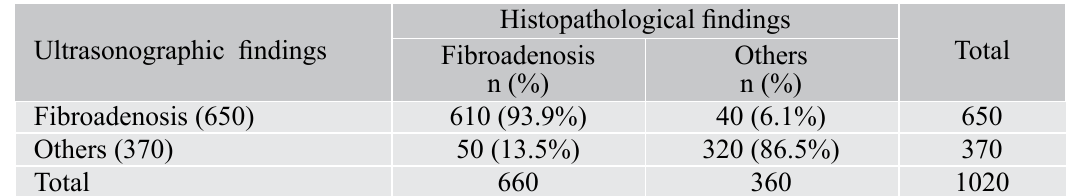
Table V: Distribution of FCCs by ultrasonographic diagnosis and histopathlogical diagnosis (n=1020)